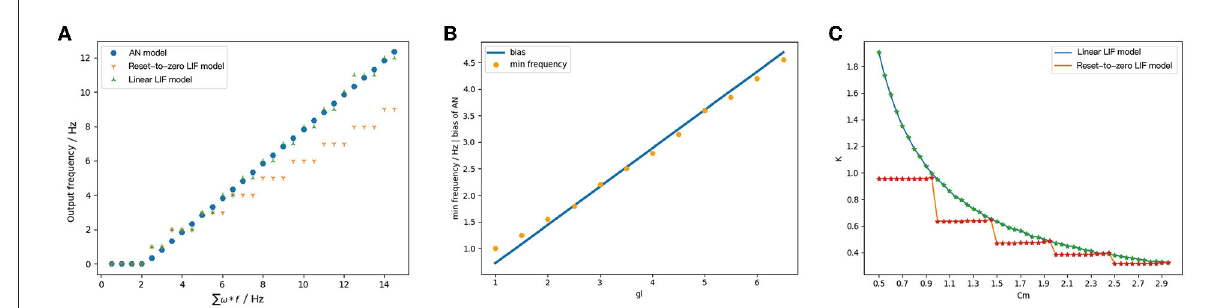
FIGURE7 (A) The output of ReLU, LIF, and Linear LIF when the input signals have the same frequency. The abscissa is the input frequency and the ordinate is the output frequency. The blue point represents the output of ReLU, the orange represents the output of the Reset-to-Zero LIF model, and the green point represents the data of the Linear LIF model. (B) The relationship between min frequency and membrane conductance. (C) The relationship between slope of activation function and membrane capacitance.